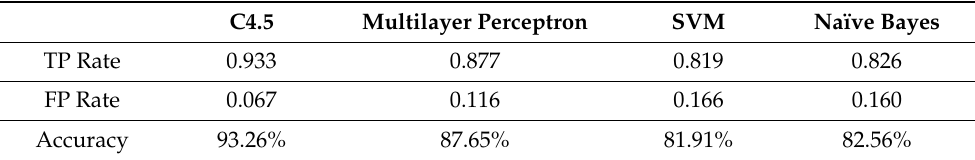
Table 7. Accuracy in detection using different